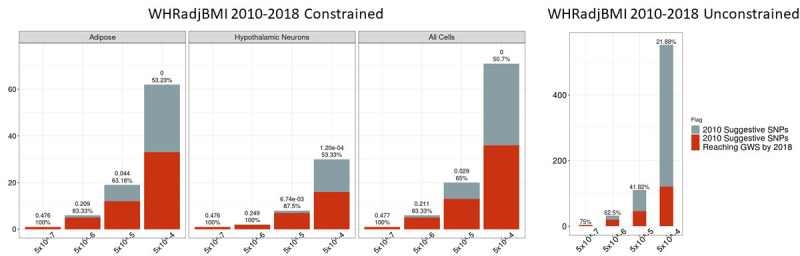
Independent 2010.WHRadjBMI SNPs salvaged via variant-to-gene mapping that go on to reach genome-wide significance by 2018, as well as the set of unconstrained 2010 suggestive SNPs that achieve genome-wide significance by 2018. Positive predictive value is depicted for each bar. Above these percentages, the p-value, as identified through Fisher’s exact test, is posted. These p-values depict the probability that the proportions of salvaged SNPs using variant-to-gene mapping differ from simply salvaging all suggestive SNPs within the same suggestive bin.Figure 6—source data 1.Number of 2010 loci identified by constrained method and the number that achieved GWS by 2018 in each cell type.Figure 6—source data 2.Number of 2010 loci identified with no constraint and the number that achieved GWS by 2018.